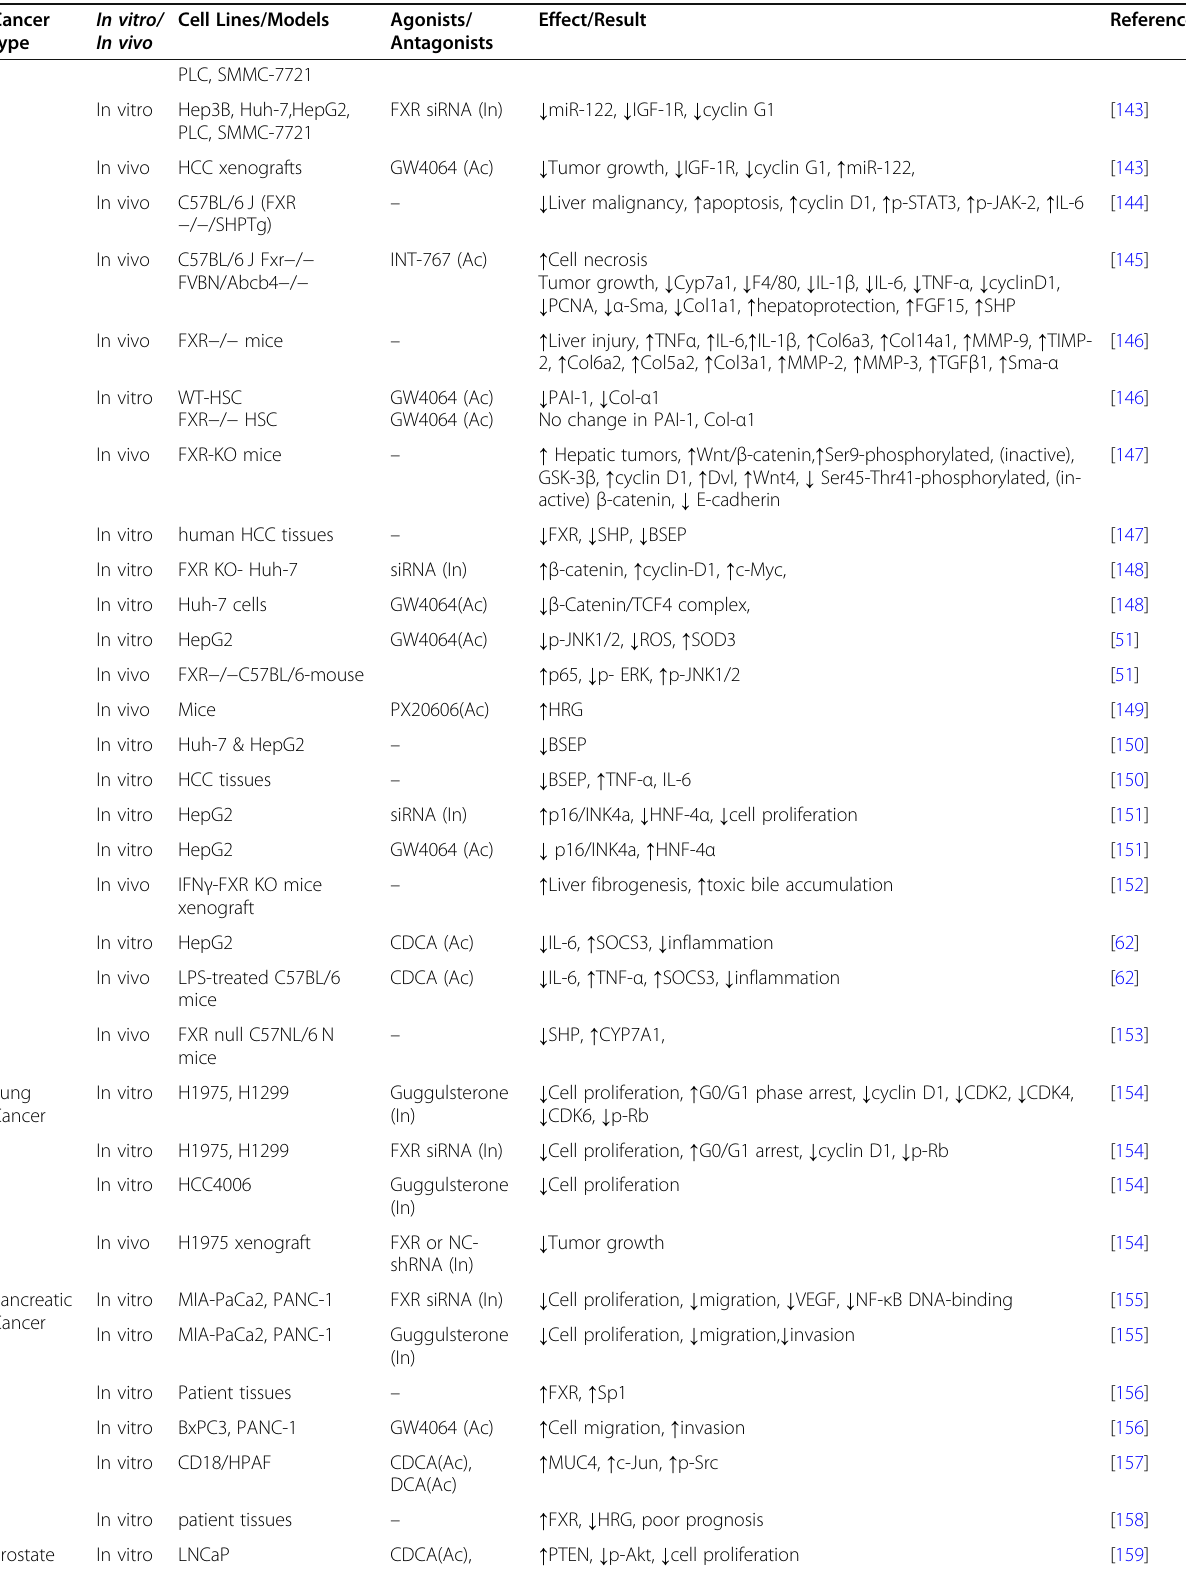
Table 1 Mechanistic role of FXR in various cancers in the presence of its agonists/antagonists (Continued) Cancer